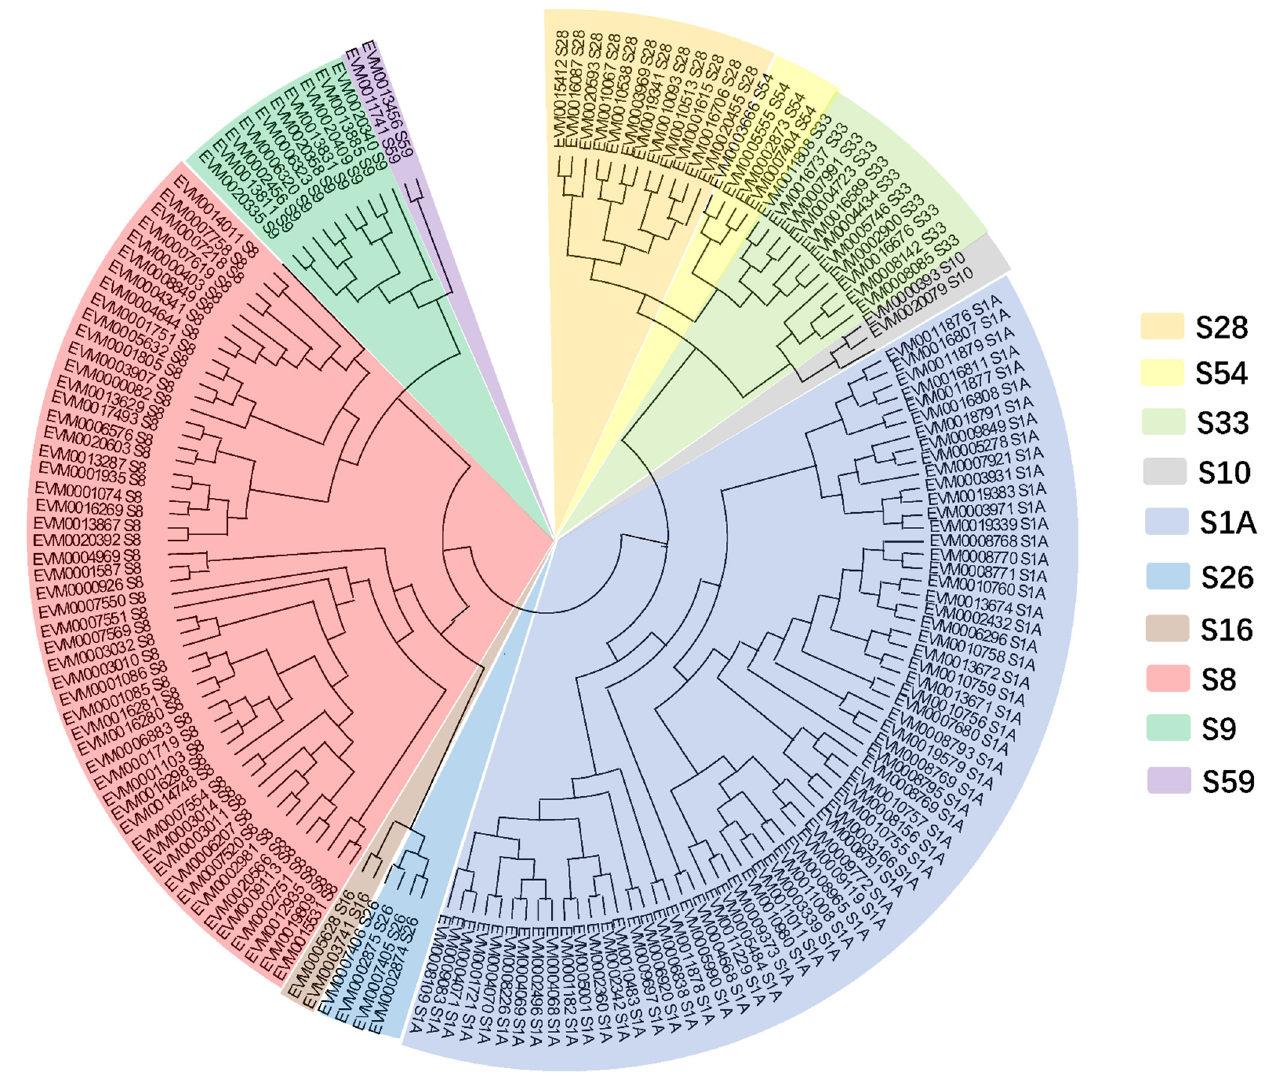
Figure 5. Phylogenetic tree for the serine proteases of C. obscurus based on the maximum likelihood method using MEGAX. Serine protease families: S1A (trypsin), S8 (subtilisin), S9 (prolyl oligopep- tidase), S10 (carboxypeptidase Y), S16 (Lon pro-tease), S26 (signal peptidase I), S28 (acid prolyl en- dopeptidase), S33 (prolyl aminopeptidase), S54 (rhomboid), and S59 (nucleoporin).